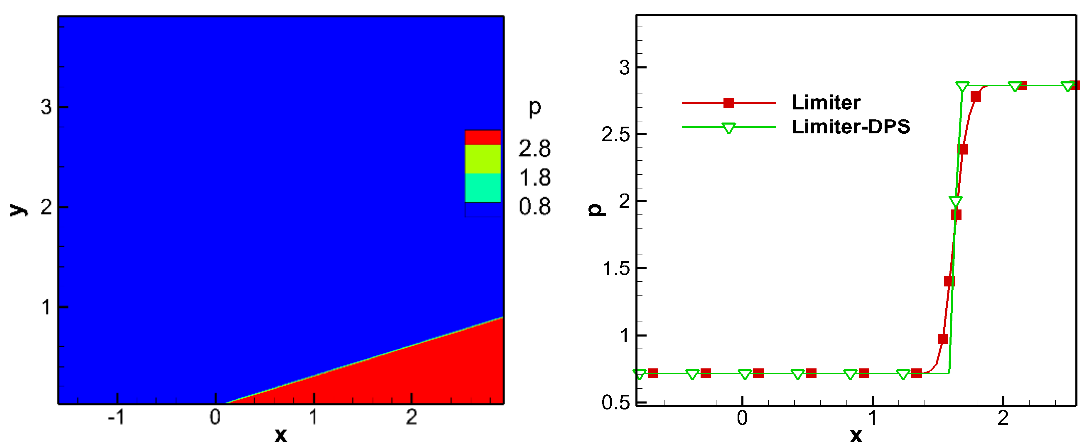
Figure 17. Pressure contour the 2-D DPS Figure 18. Pressure plot of 2-D DPS and